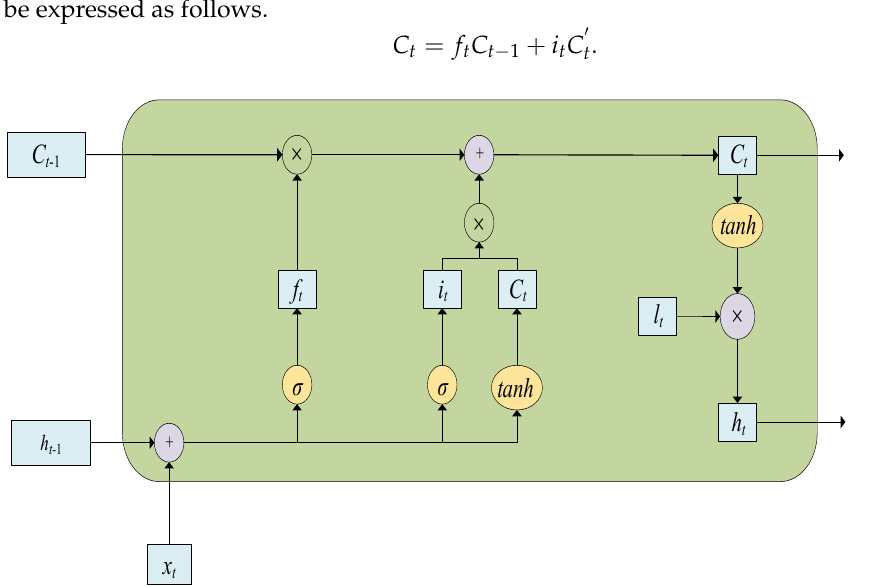
Figure 4. The structure diagram of the LSTM memory